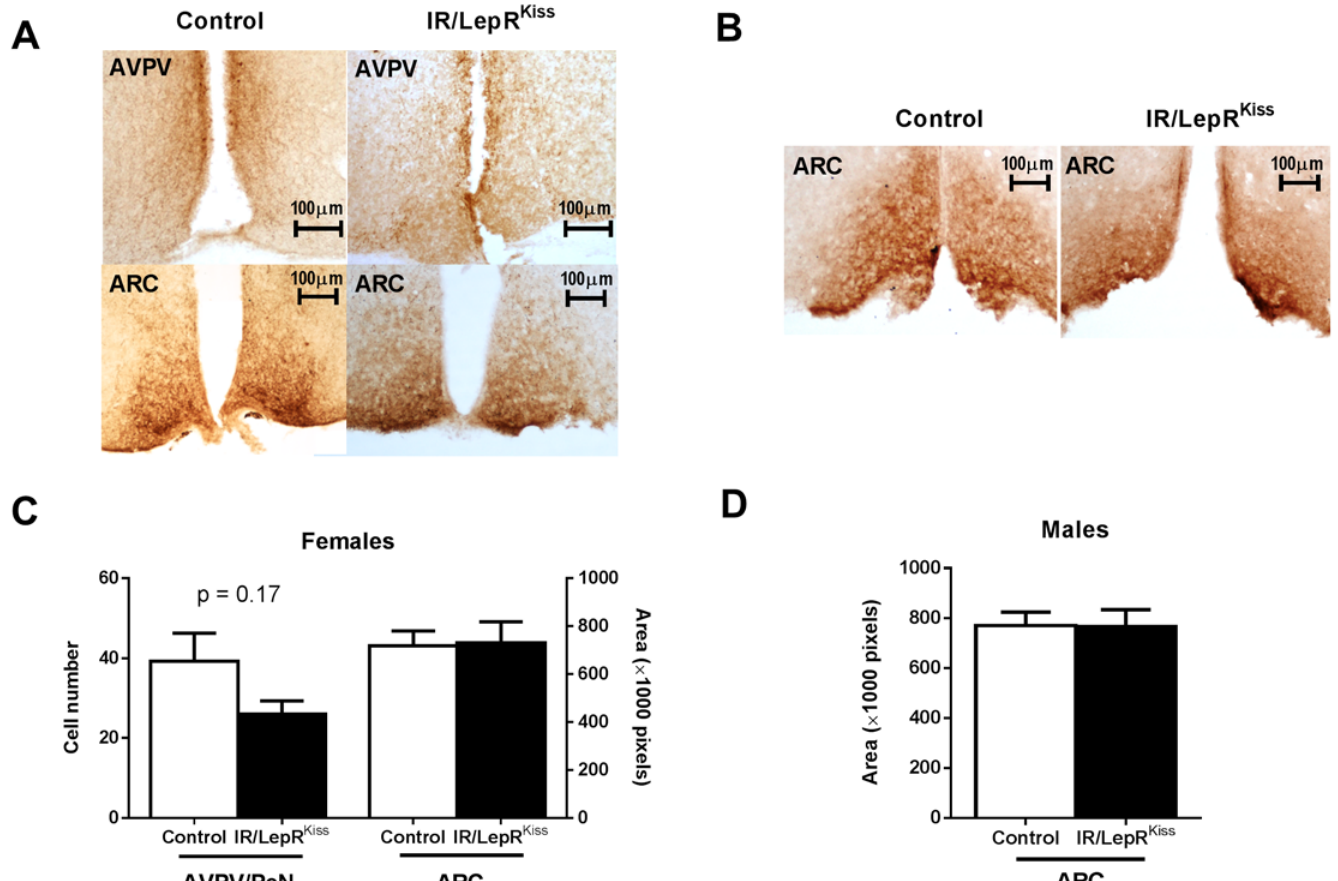
Fig 5. Kisspeptin cell number and process density in IR/LepR Kiss females. (A) Female representative Kiss1 immunostaining: Upper left square = AVPV/ PeN of control mouse, lower left square = ARC of control mouse, upper right square = AVPV/PeN of IR/LepR Kiss mouse, lower right square = ARC of IR/ LepR Kiss mouse. Left square = ARC of control mouse, right square = ARC of IR/LepR Kiss mouse. (B) Male representative Kiss1 immunostaining (C) Quantification of Kiss1 cell number in the AVPV/PeN (n = 2, n = 4 mice) and Kiss1 immunoreactive area in the ARC (n = 4, 4) of adult females. (D) Quantification of Kiss1 immunoreactive area in the ARC in adult males (n = 3, 3). AVPV/PeN, anteroventral periventricular and anterior periventricular nuclei; ARC, arcuate nucleus.